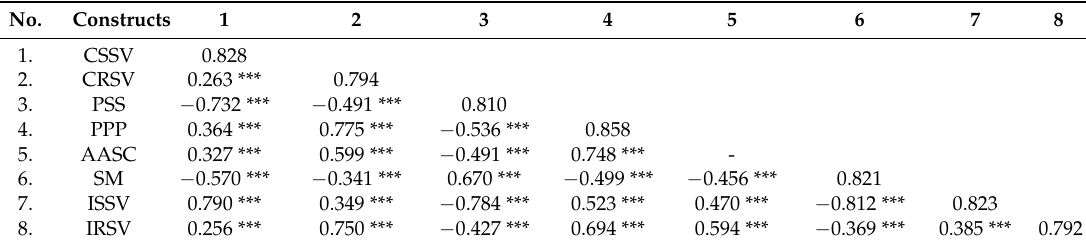
Table 4. The results of discriminant validity